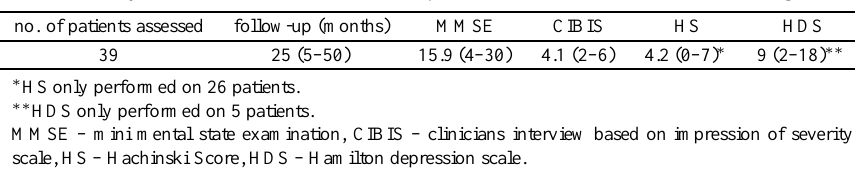
Table 2 The number of patients considered most likely to have a particular disease